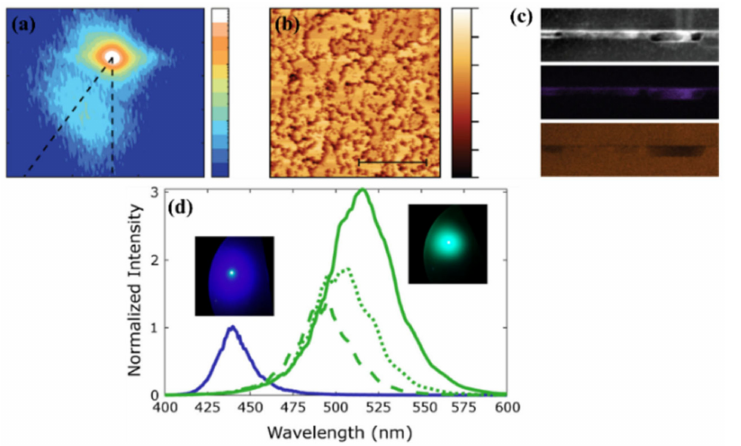
Figure 7. ( a ) RSM and ( b ) AFM of as-grown epitaxy. ( c ) TEM of the DL after high-temperature GaN growth; ( d ) comparison of PL emission from MQWs regrown on GaN template and relaxed InGaN buffer. These figures are reproduced from [22], with the permission of AIP